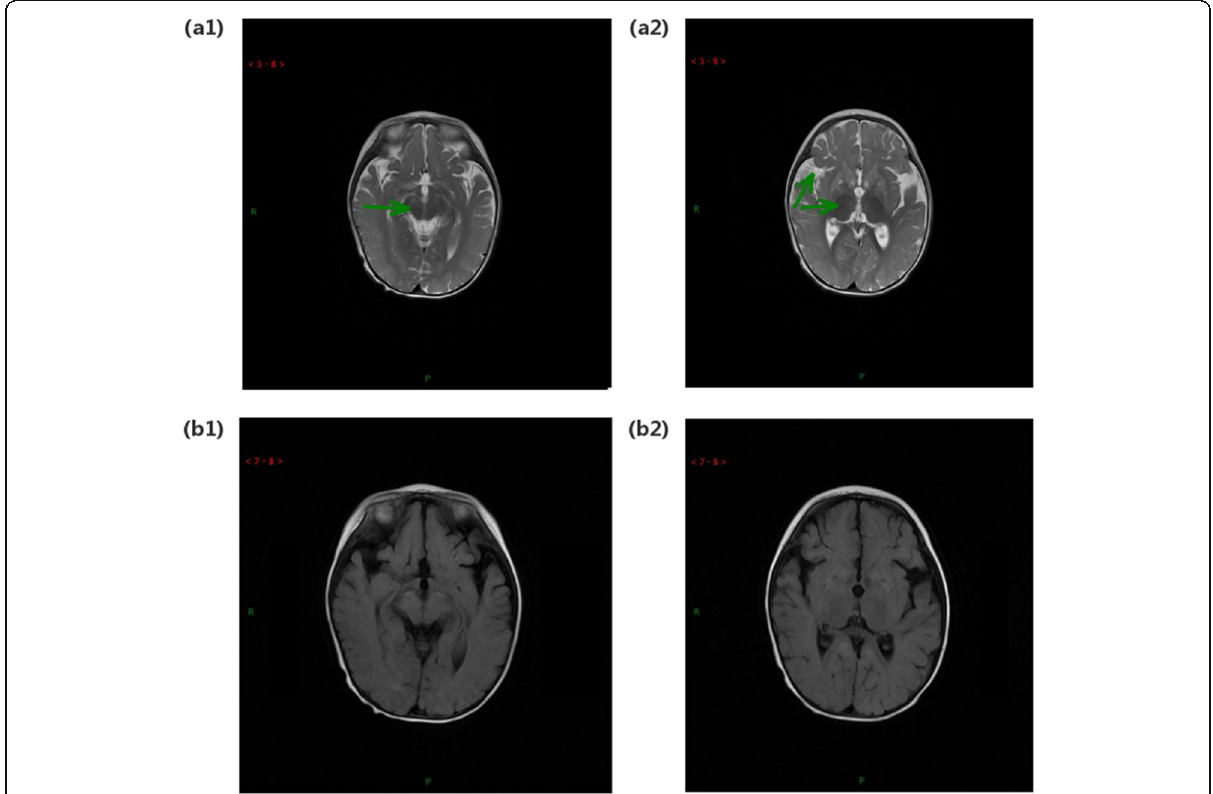
Fig. 1 MRI and MRS of patient P4. Images (a1) and (a2) are T2-weighted images, with green arrows showing abnormal areas. (b1) and (b2) are T2-FLAIR